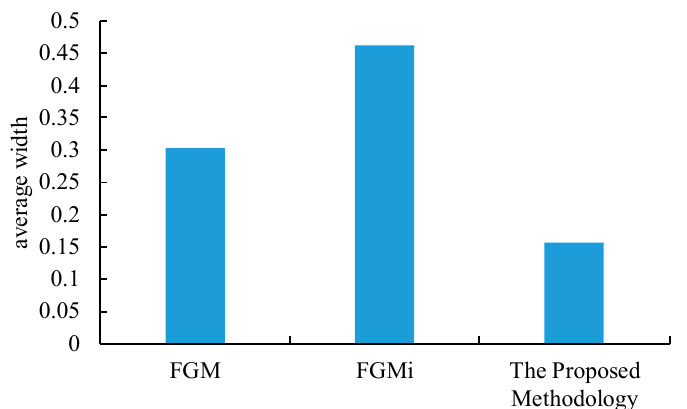
Figure 10. The average widths of the fuzzy weights estimated using various methods.